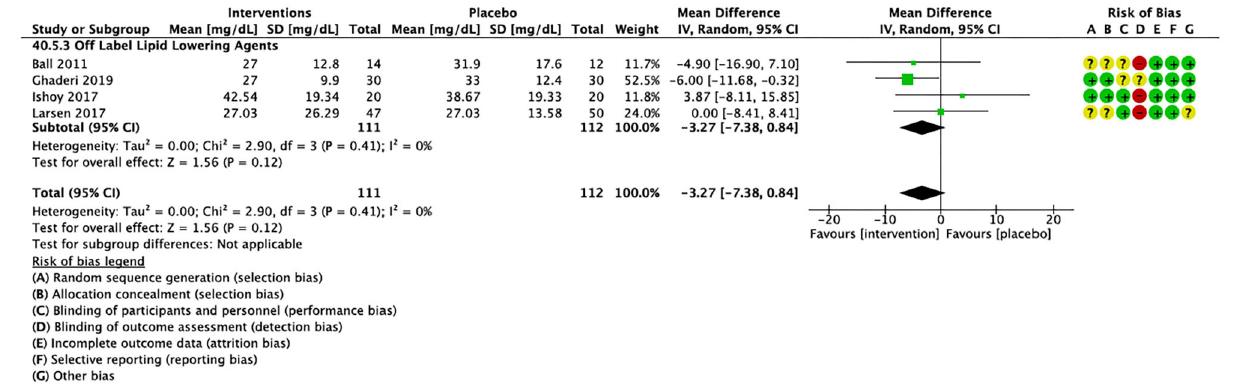
− 0.89, − 0.15; p = 0.005) compared to placebo. Blood